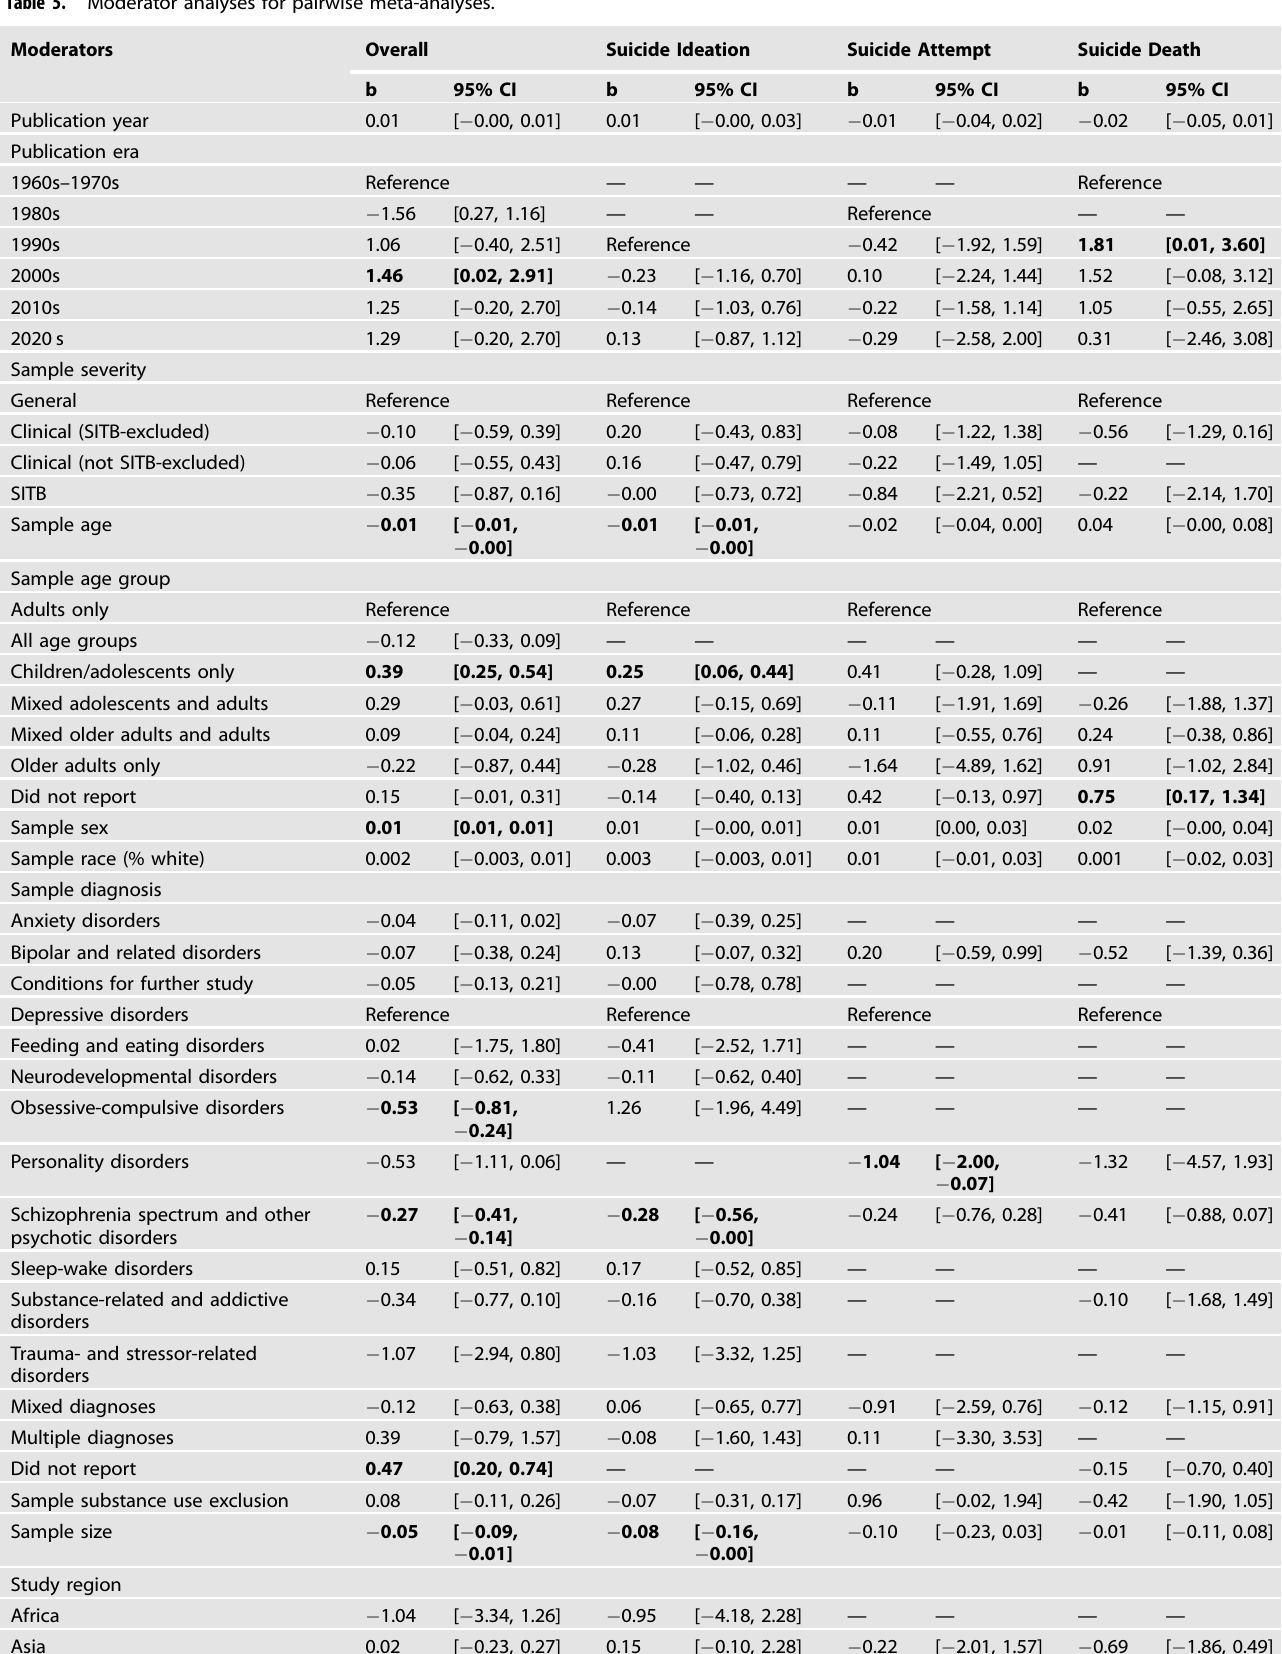
Table 5. Moderator analyses for pairwise